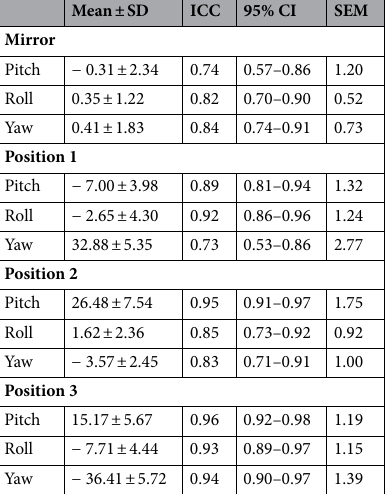
Table 2. Characteristics of the natural head position achieved in front of a mirror and each of three hunter positions. Means and standard deviations (SD) are shown for each position and each axis within each position, for the 30 participants. Intraclass correlation 19 , 95% confidence intervals (CI), and standard error measurements (SEM) are also